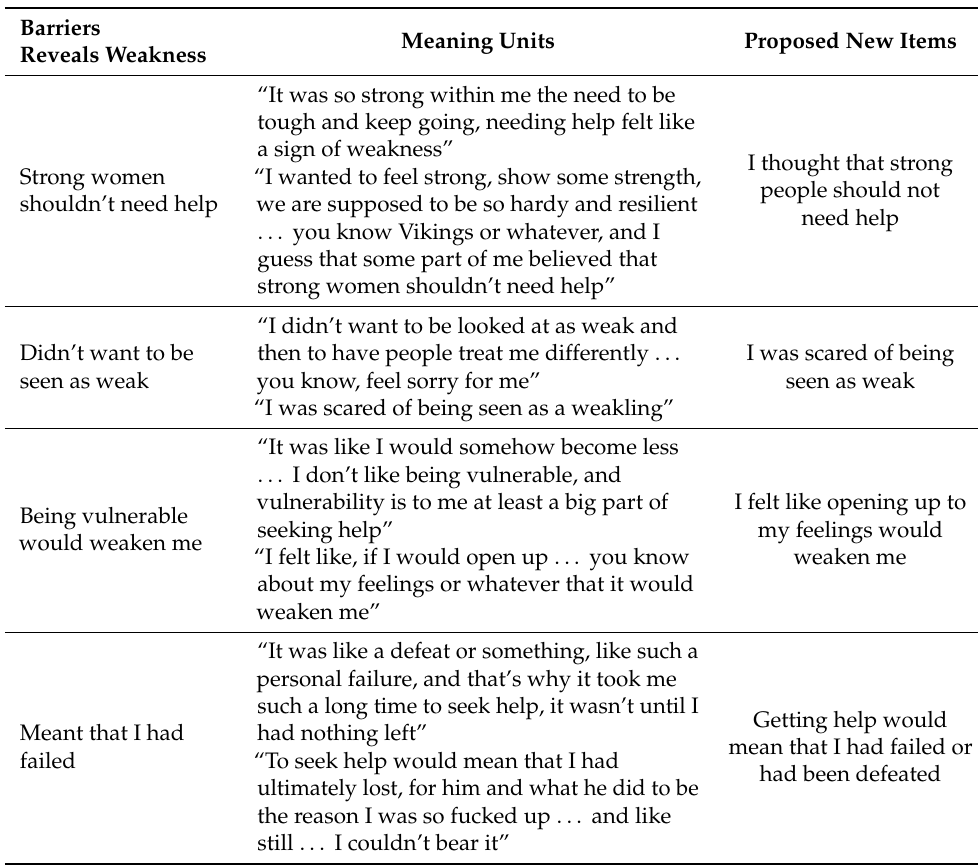
Table 3. Reveals weakness